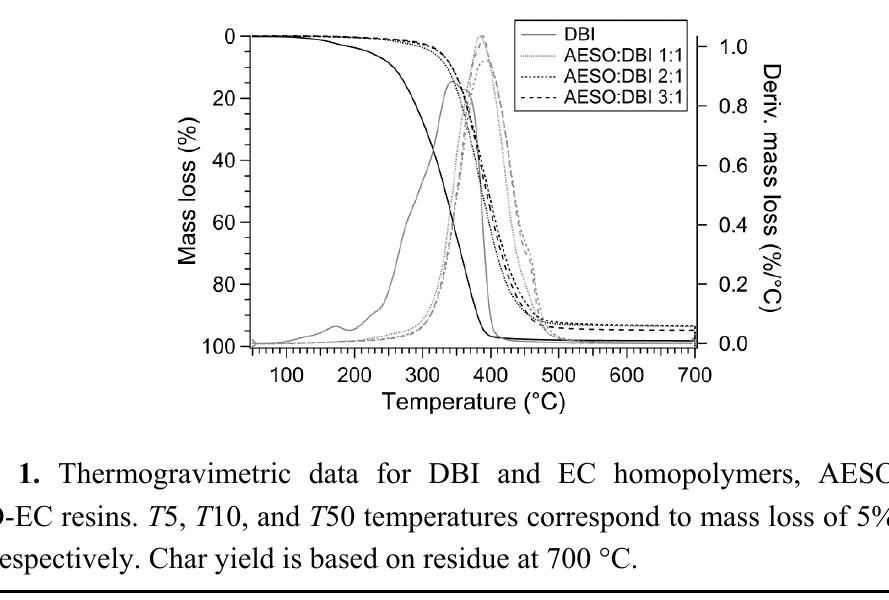
Figure 4. Thermogravimetric curves for poly(DBI) and AESO-DBI thermosets. Black traces correspond to mass loss vs . temperature; gray traces are the corresponding derivative plots.